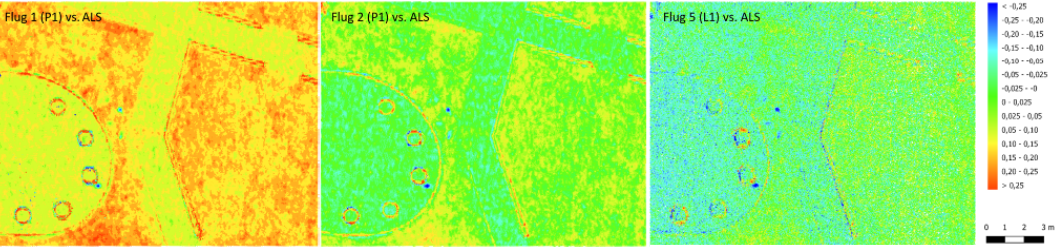
Figure 14 . Comparison of point clouds of airborne laser scanning with the RIEGL VQ-780II to point clouds of UAV flights 1, 2 and 5 on test area